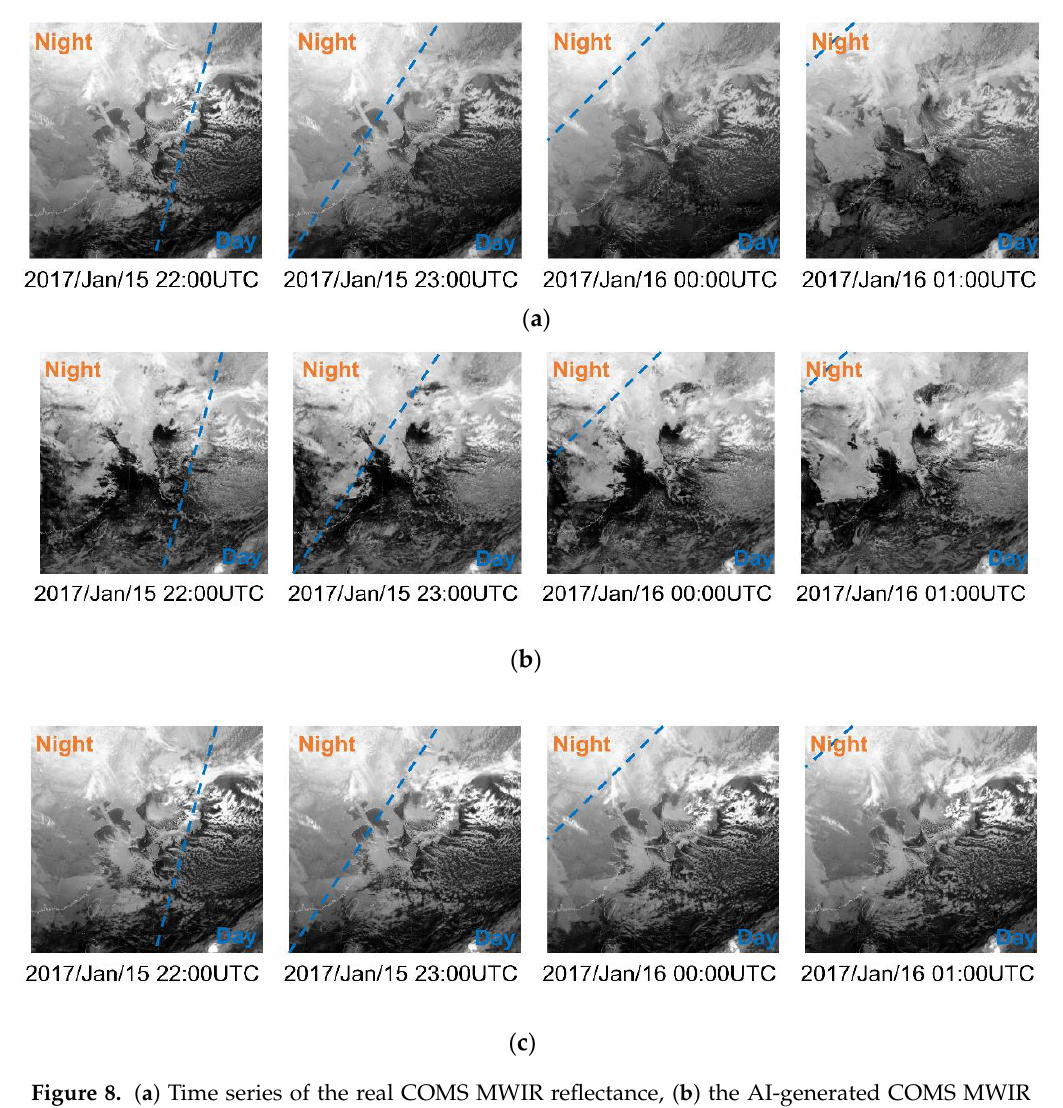
Figure 7. Time series of the CC, bias, and RMSE at every 25th day in each month from January to December 2017.